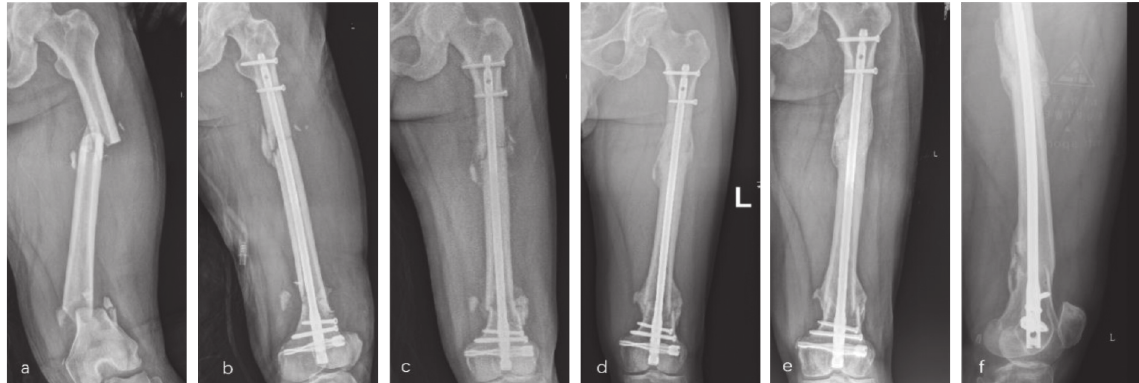
Figure 4: Male, 33, multi-fragment fracture of left femur with AO classification B3 in shaft, and A2 in distal part (a). Treated with retrograde nailing and postoperative MDI, 1-day postoperative radiograph (b). 1month (c), 3-month (d) follow-up radiographs. 1-year follow-up radiographs indicated union (e,